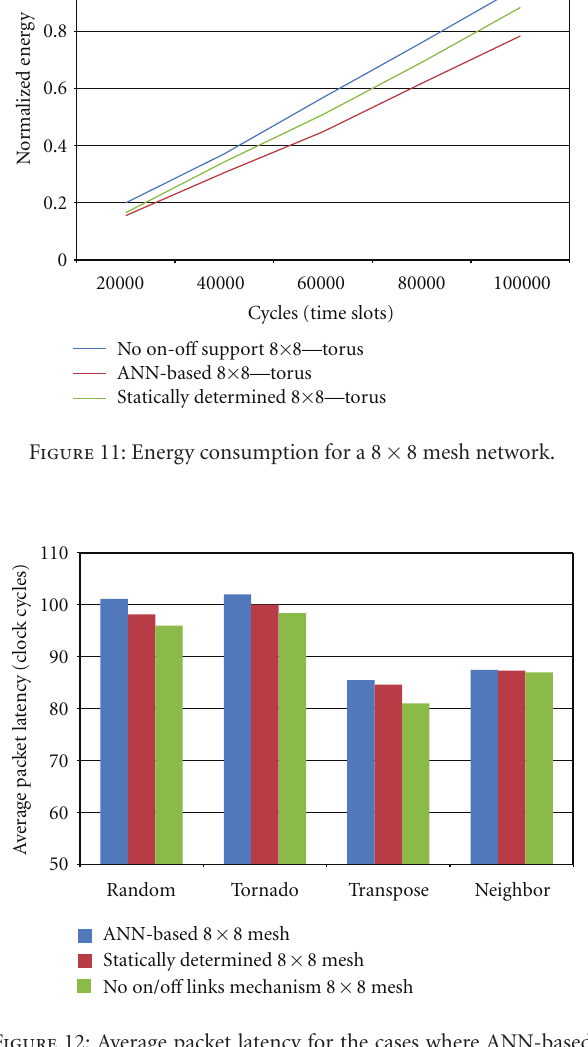
Figure 12: Average packet latency for the cases where ANN-based mechanism is used, when trivial case is used and when there is no on/o ff